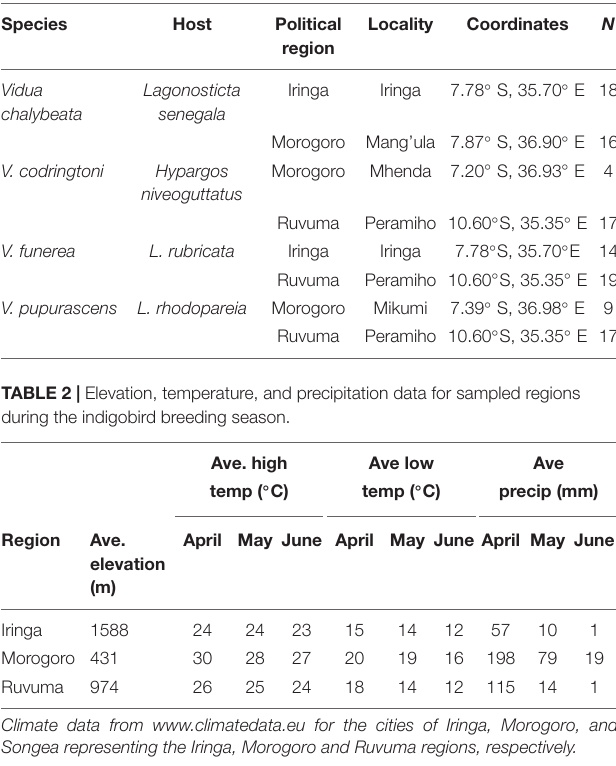
TABLE 1 | Locality and sampling information ( N = number of recorded males).